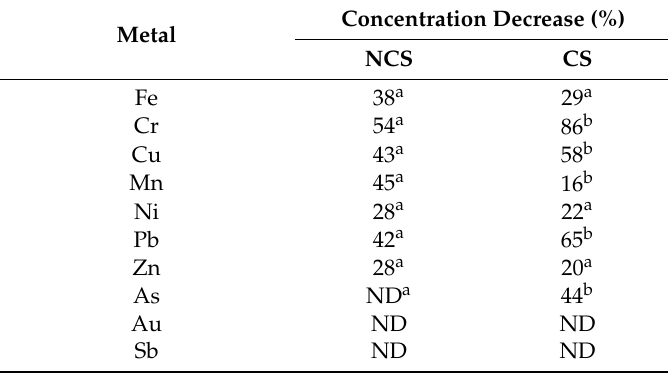
Table 2. Metal decrease percentages in NCS and CS soils after 90 days. Metal